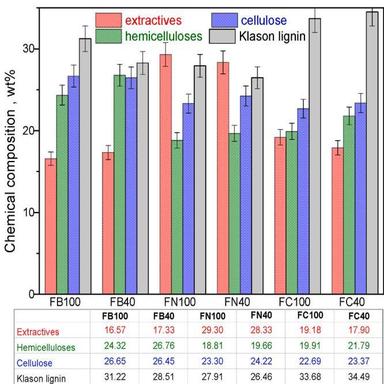
Composition by chemical methods for the biomass residues of 40 and 100 years old.